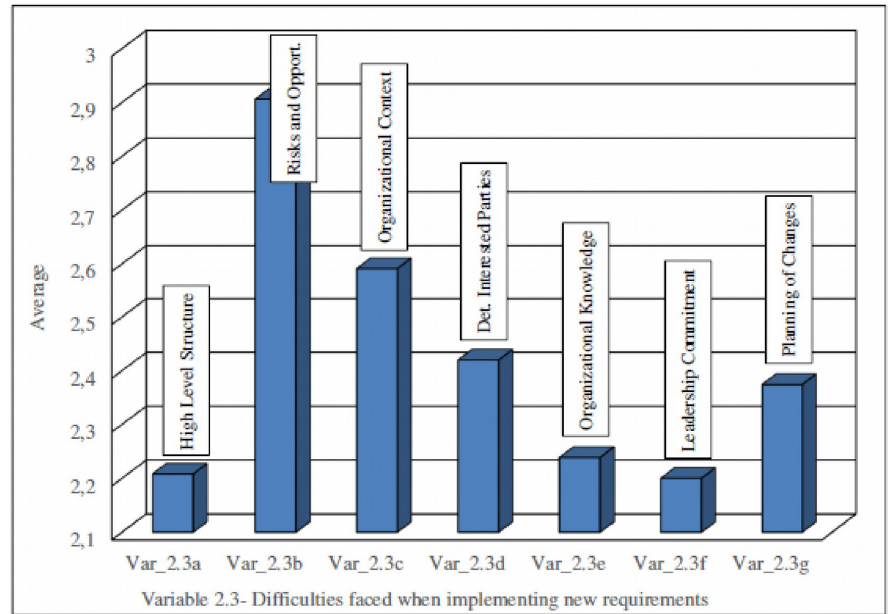
Figure 2. Average values of the difficulties faced by the organization when implementing the new ISO 9001:2015